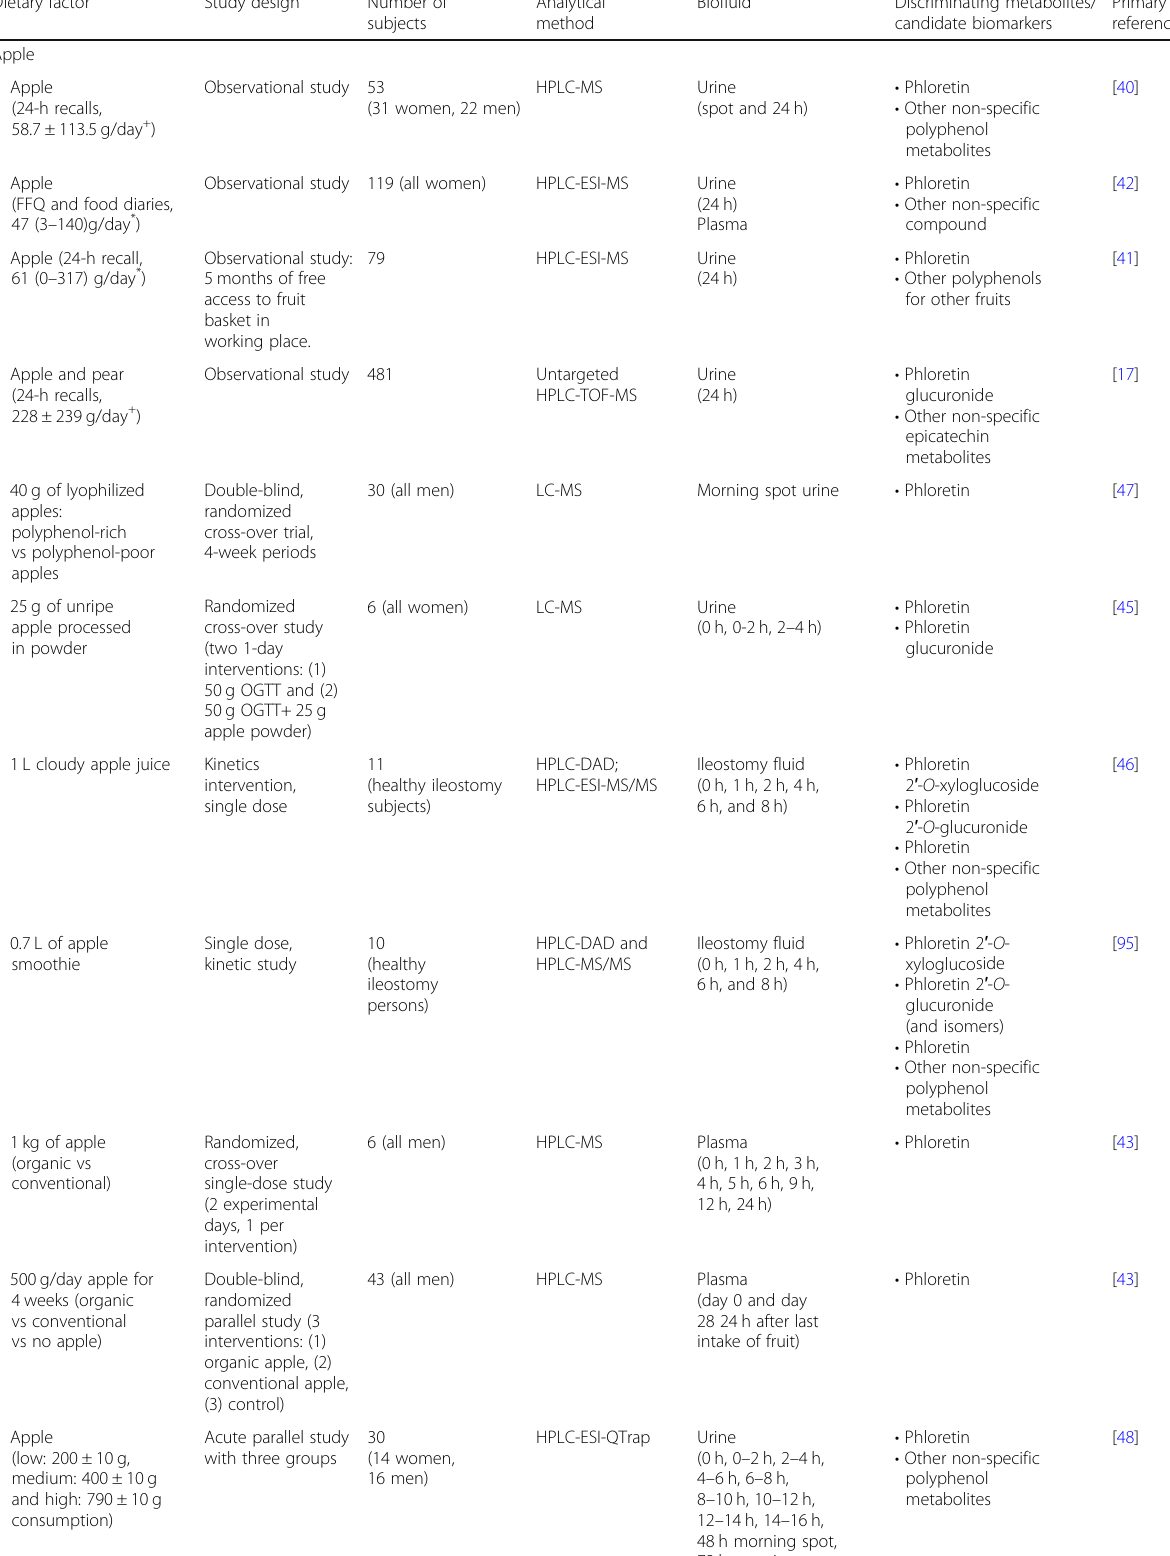
Table 1 List of studies reporting candidate biomarkers for pome fruit consumption Dietary